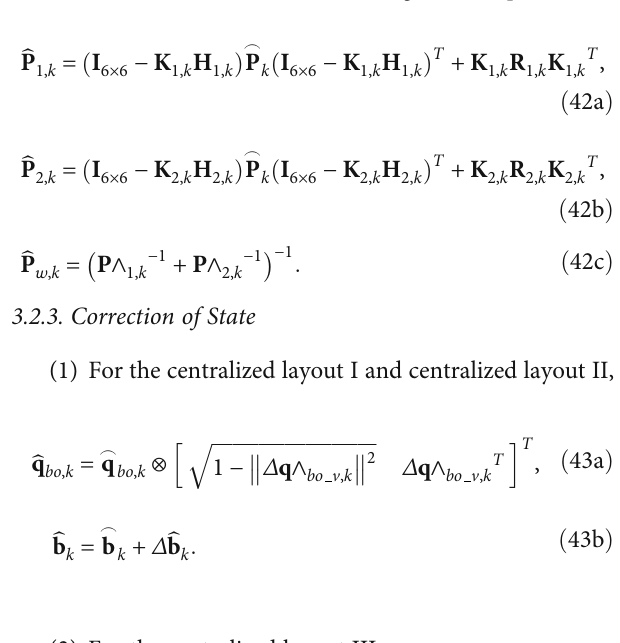
Figure 9: Estimation error of Euler angles (stable